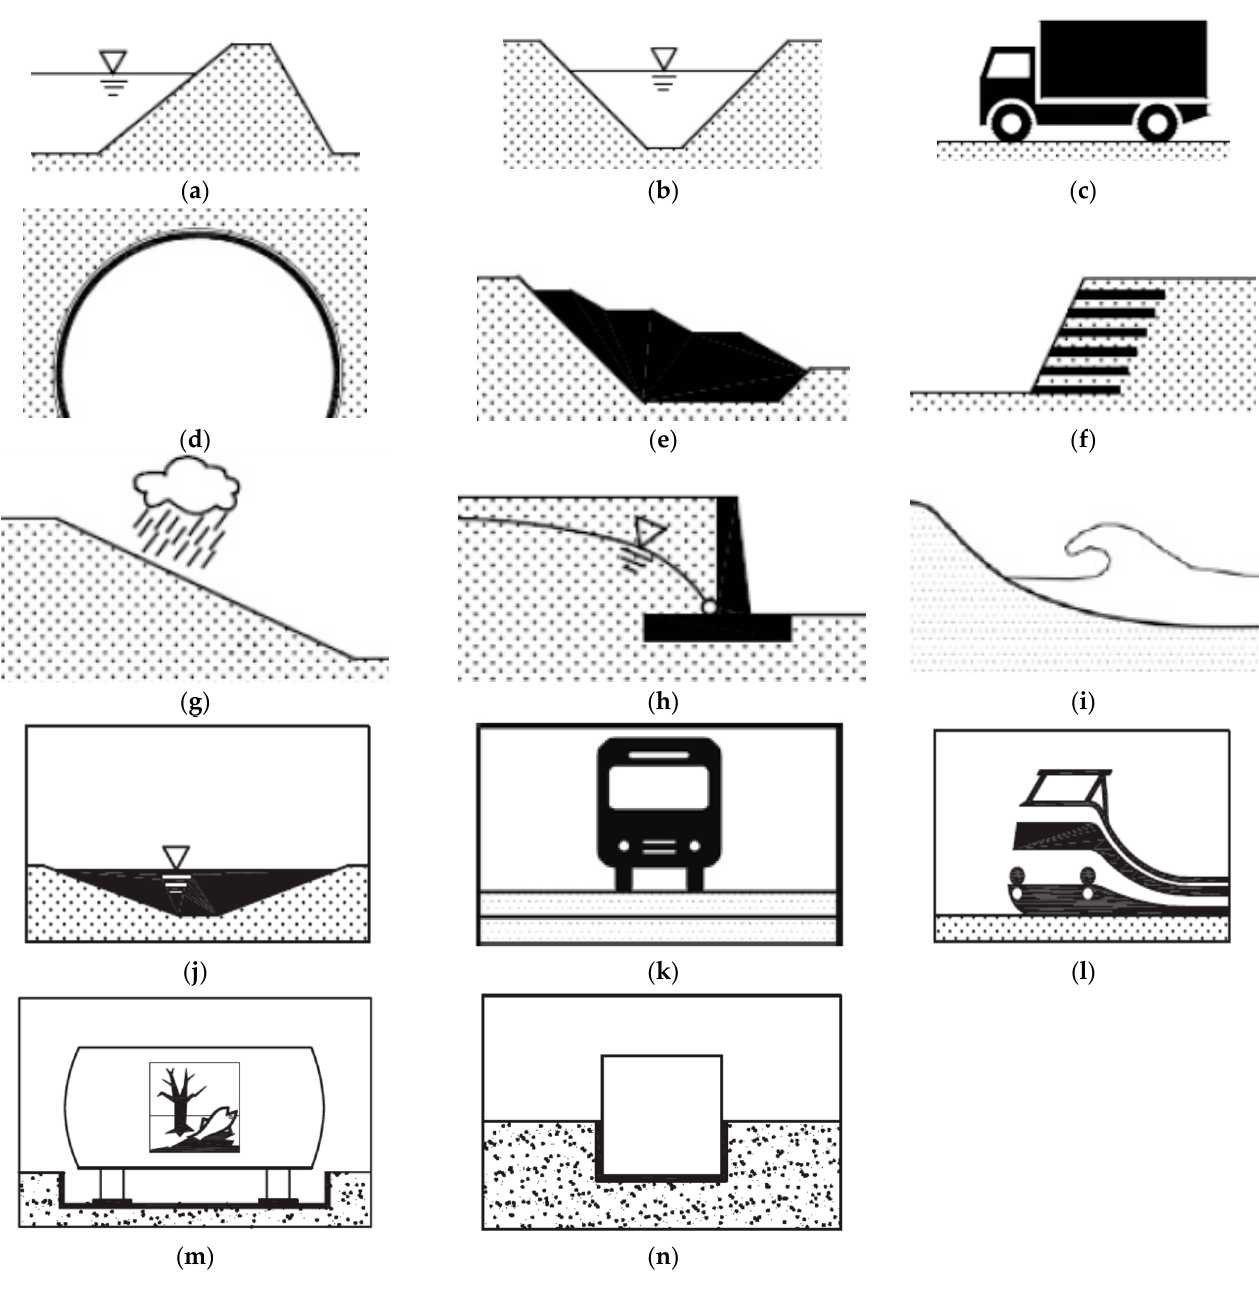
Figure 8. Applications of geosynthetics: ( a ) reservoirs and dams; ( b ) canal; ( c ) road; ( d ) tunnel and underground structures; ( e ) landfill; ( f ) retaining wall; ( g ) surface erosion control system; ( h ) drainage system; ( i ) coastal protection; ( j ) liquid waste; ( k ) asphalt reinforcement; ( l ) railways; ( m ) secondary containment; ( n ) waterproofing and underground structures [47,48].